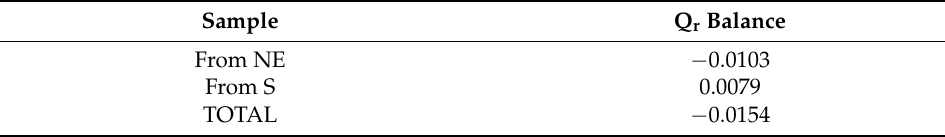
Figure 7. Field mast distribution and main wind directions. Table 2. Sediment transport rate (Q r ) balance.